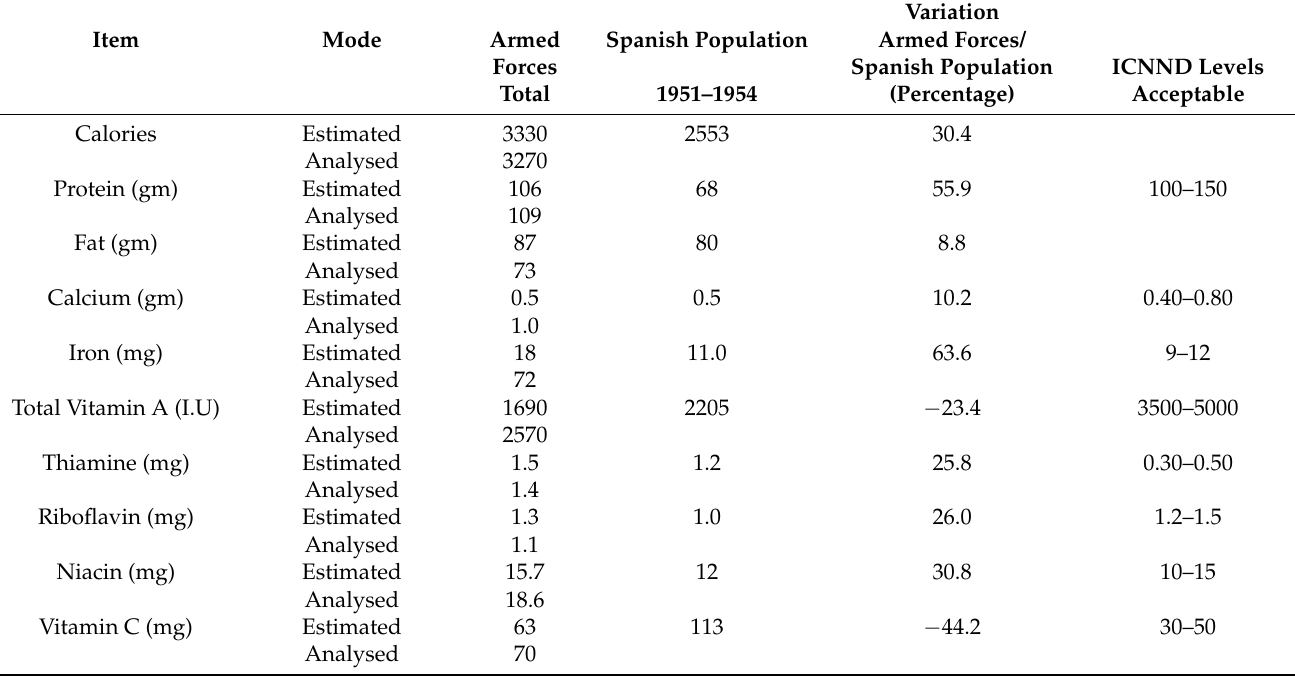
Table 10. Daily intake of nutrients in military mess halls and the Spanish population as a